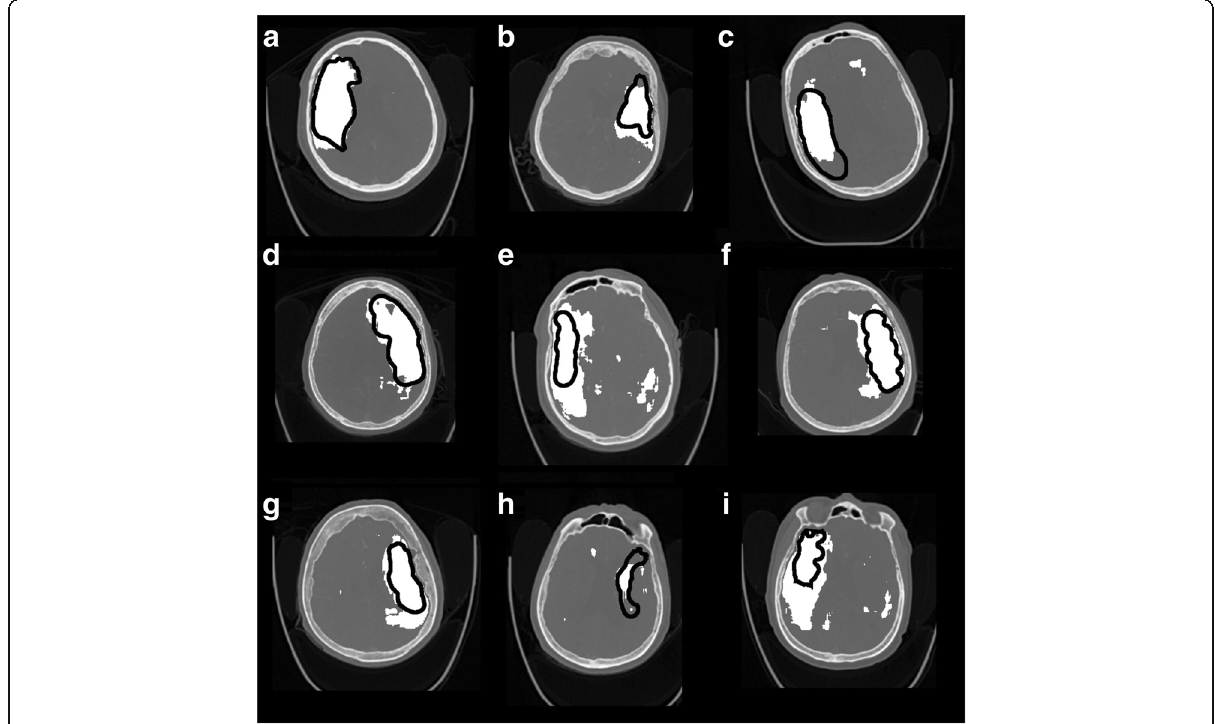
Fig. 2 Representative slices of nine ( a - i ) of the infarct positive test cases. 3D CNN output with CTA + cerebral hemispheric comparison + NCCT features are shown in white, and the infarcted lesion drawn manually is indicated with black